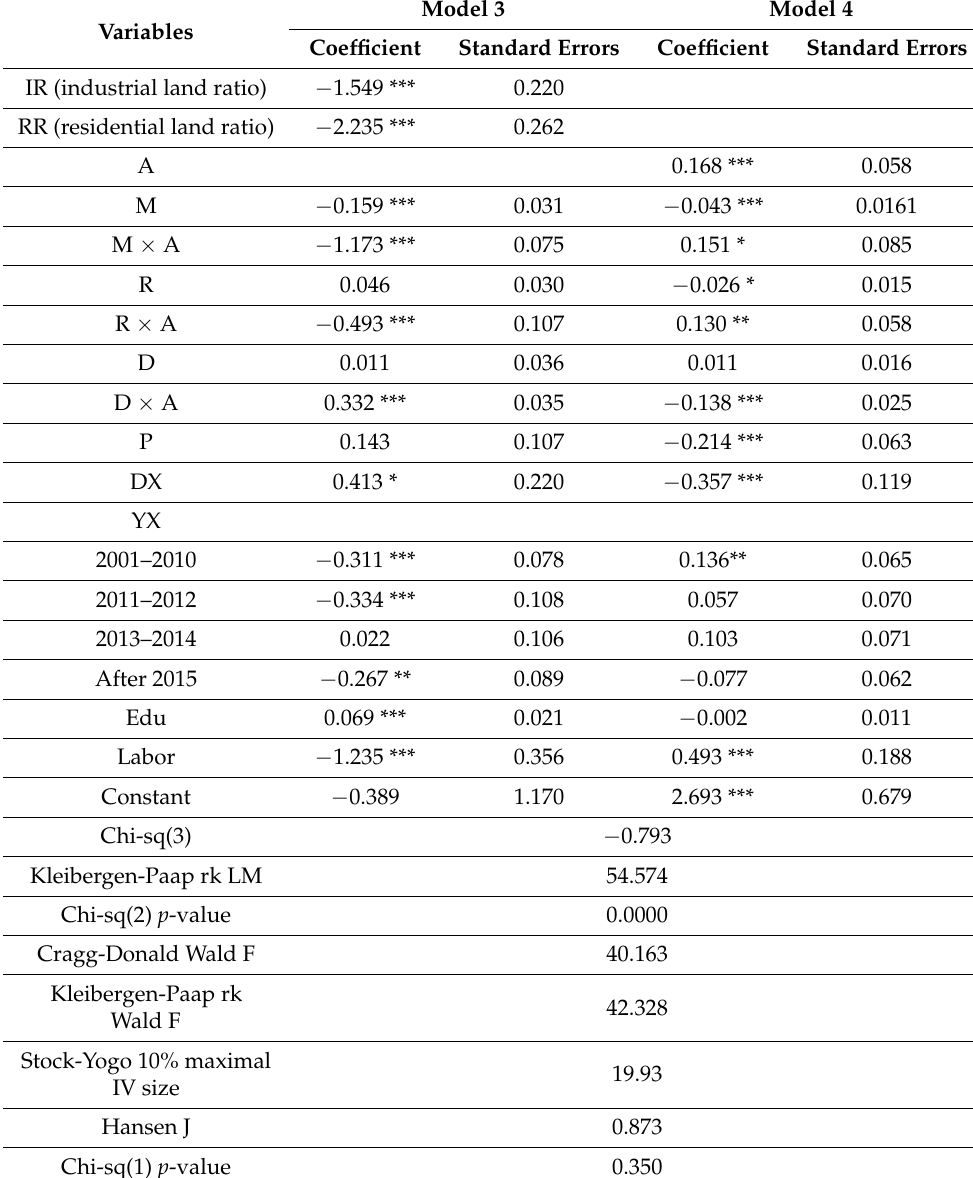
Table 3. Results of two-stage instrumental evidence for the effect of job